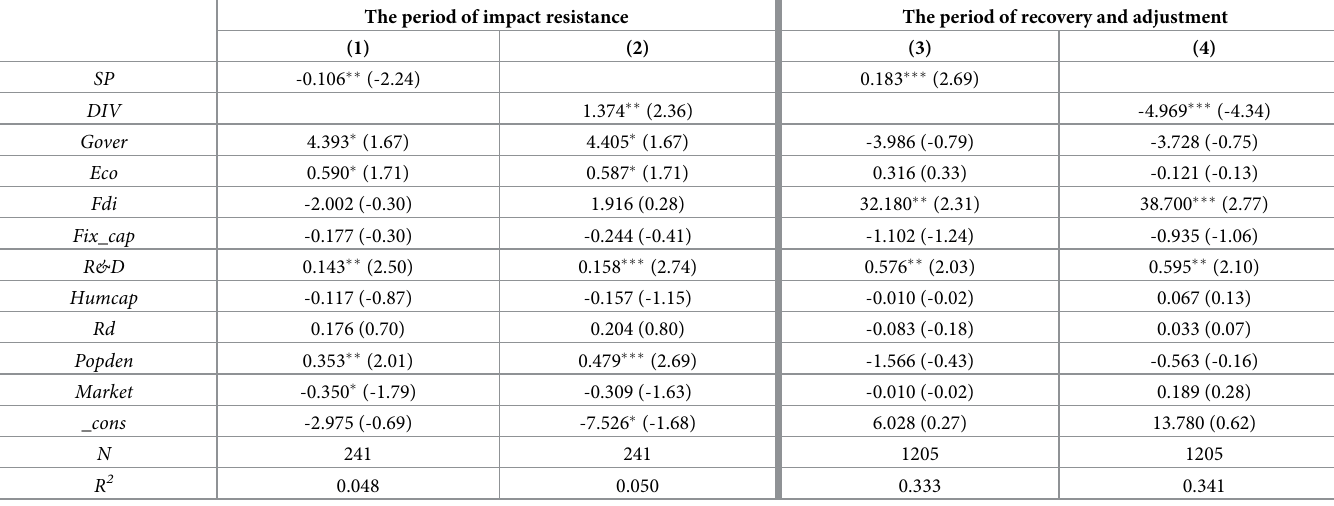
Table 2. The effects of two types of industrial agglomeration on urban economic resilience.